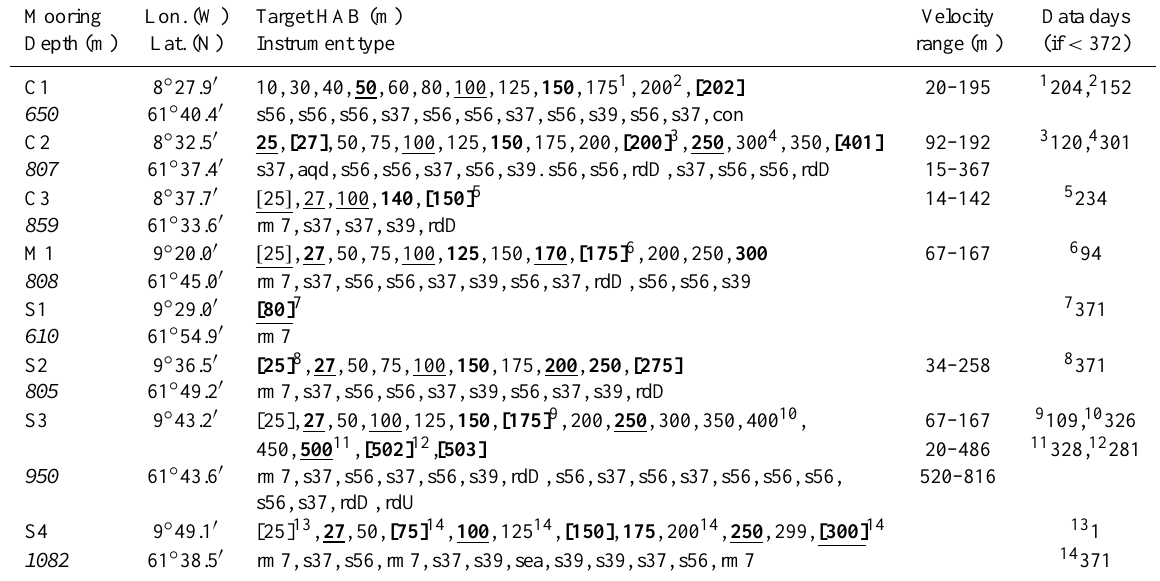
Table A1. Mooring positions, instrumentation, and data return. The nominal depth level of each instrument is given as height above bot- tom, HAB (m). Temperature is measured at every level, and any additional parameters measured are indicated as follows: conductivity as underlined, pressure as bold, and velocity in square brackets. The full deployment length was 372 days; any shorter records are marked by superscripts and the record length given in the column on the right. For current profilers, the target range is shown in a separate column. Instrument types are abbreviated as follows: SBE37 (s37), SBE39 (s39), SBE56 (s56), Continental (con), downward-looking RDI (rdD), upward-looking RDI (rdU), Aquadopp (aqd), RCM-7 (rm7), and Seaguard (sea). Three of the short records (superscripts 3, 6, and 9) are from the downward-looking RDI ADCPs at moorings C2, M1, and S3, respectively, that were set at a higher sampling resolution.